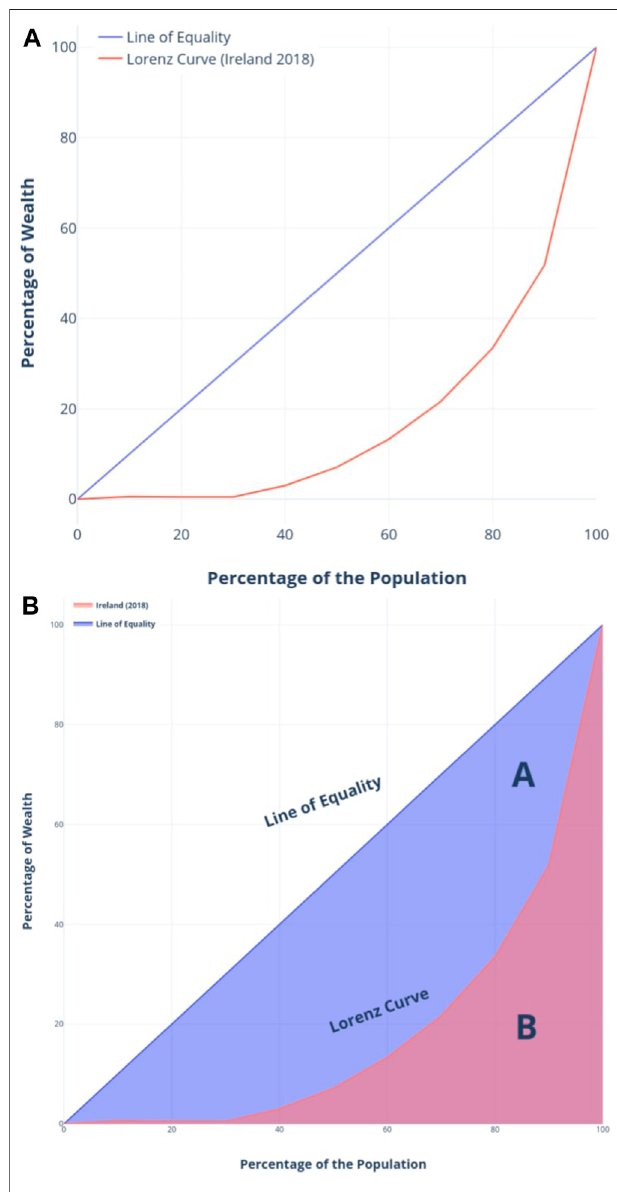
FIGURE 1 | Lorenz curve for Irish Economy in Year